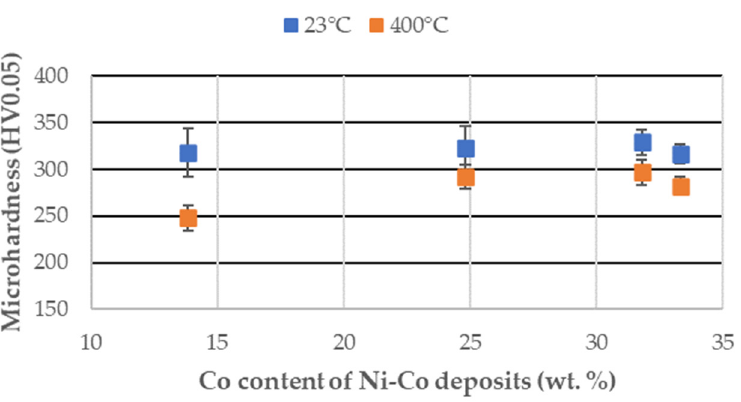
Figure 5. Microhardness in dependence on Co content in Ni-Co coatings at the temperatures of 23 °C and 400 °C.